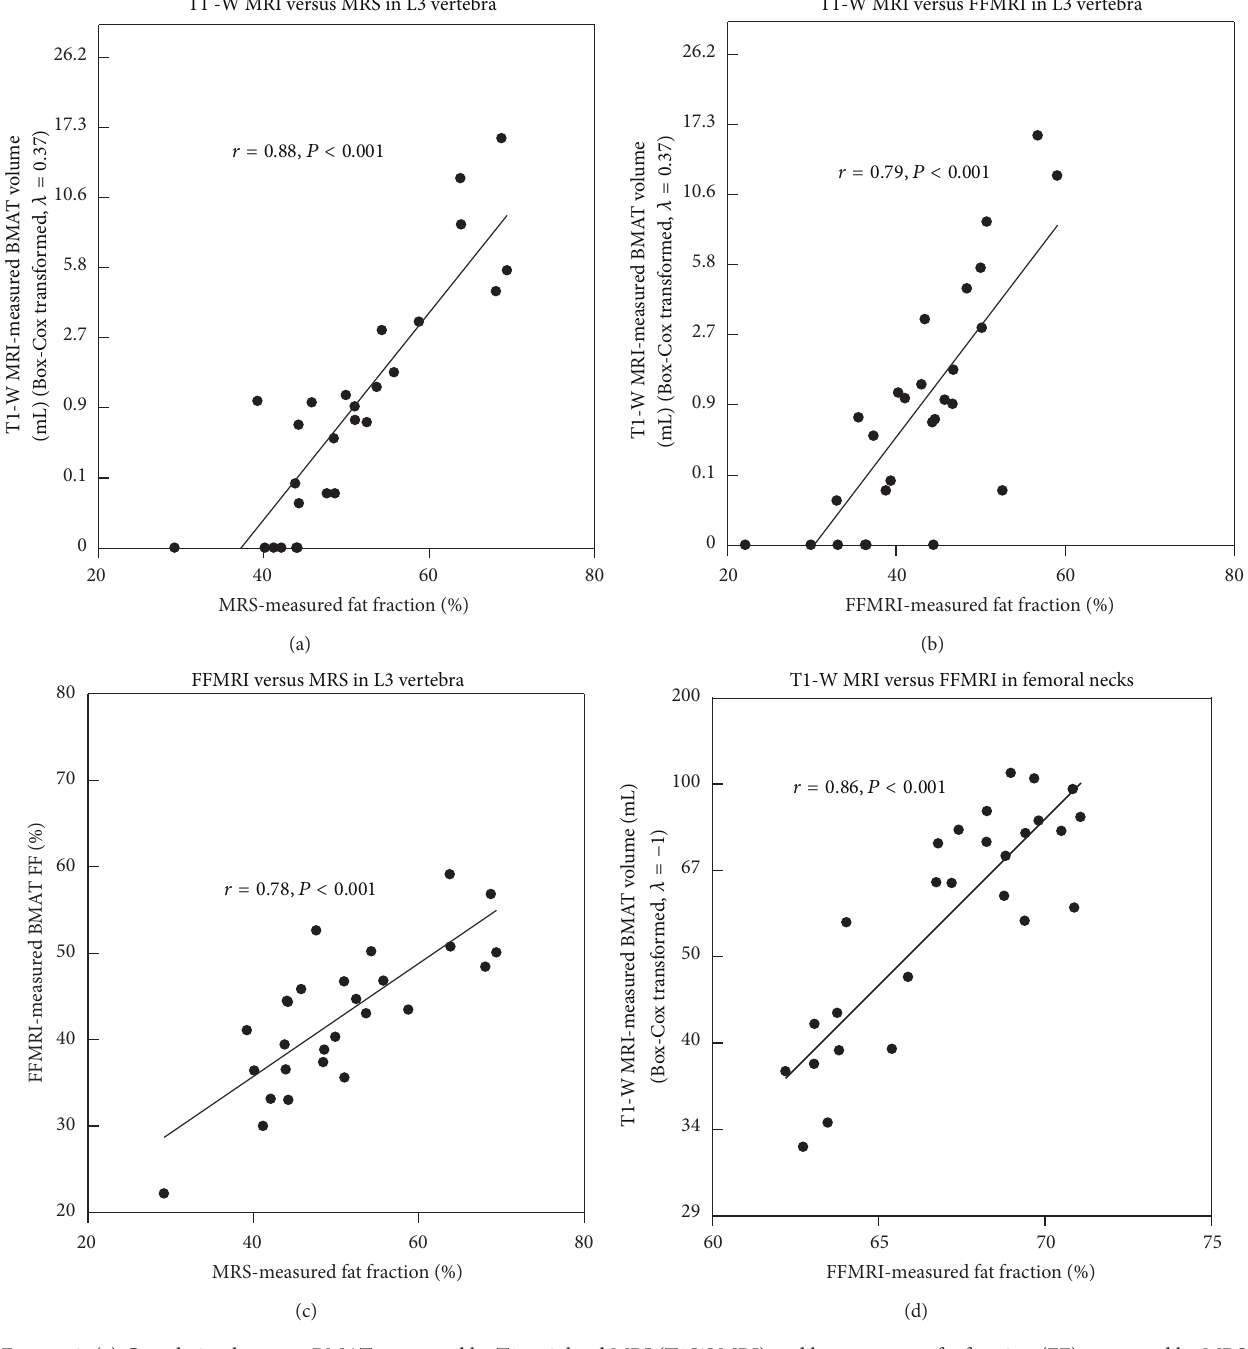
Figure 2: (a) Correlation between BMAT measured by T1-weighted MRI (T1-W MRI) and bone marrow fat fraction (FF) measured by MRS in L3-vertebra; (b) correlation between BMAT measured by fat fraction MRI (FFMRI) and bone marrow fat fraction measured by MRS in L3-vertebra; (c) correlation between BMAT measured by T1-weighted MRI and bone marrow FF measured by FFMRI in L3-vertebra; (d) correlation between BMAT measured by T1-weighted MRI and bone marrow FF measured by FFMRI in femoral